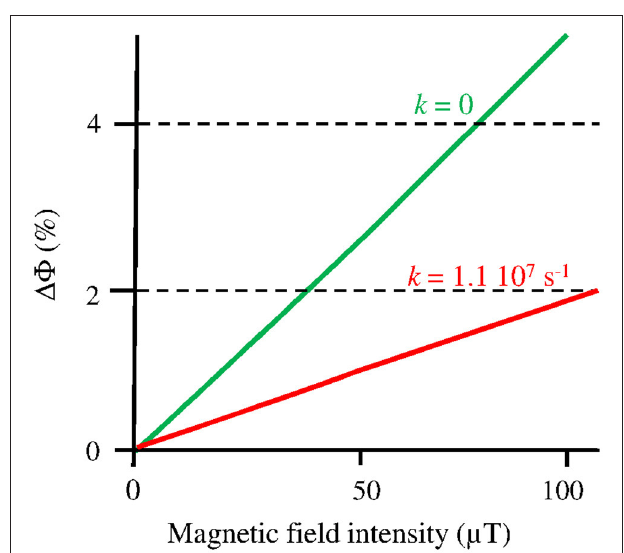
FIGURE 2 | Change (%) of the yield ( 8 ) of FADH • in At Cry 1, thus of the constant k 1 of its photoreduction, according to the intensity B of a static MF under flash photolysis (adapted with permission from Maeda et al., 2012, © National Academy of Sciences of the United States of America). The graph focuses on the Earth strength range, where the MF effect is to increase 8 ( k 1 ). The function 18 ( B ) is shown here for k STD ( k ) = 1.1 10 7 s − 1 , where it best fits the experimental observations, and for k STD = 0, which can be the case in vivo (see